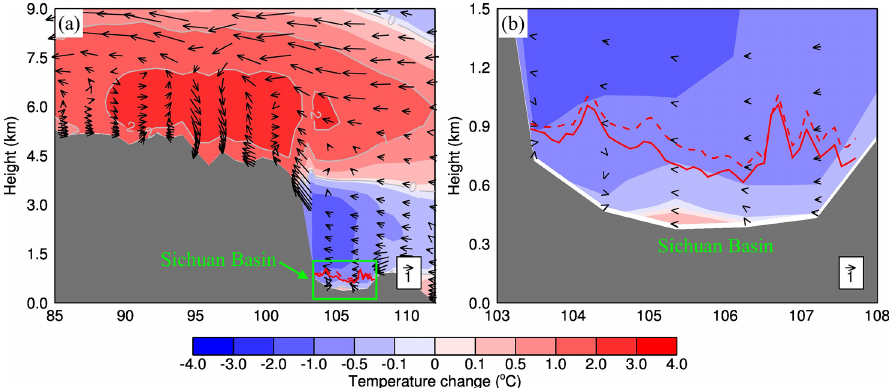
Figure 10. Vertical profiles of changes in temperature (shading and gray contour) and winds (arrows) along 30 ◦ N in January 2014. The gray shaded area presents topography. The green box shows the Sichuan Basin, and the red solid (baseline simulation) and dashed (sensitivity simulation) lines show the PBL height. (a) The Tibetan Plateau and Sichuan Basin; (b) the Sichuan